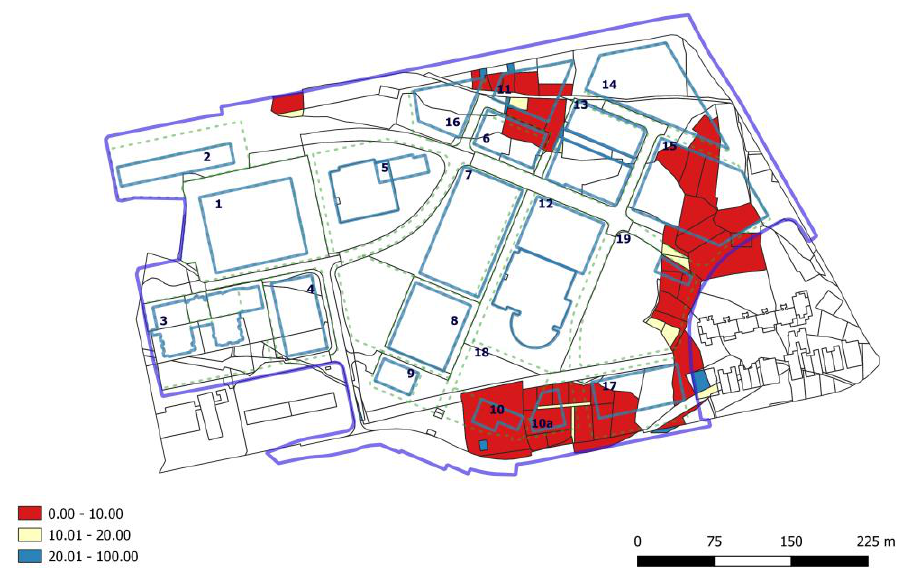
Figure 6. Performance Index of private cadastral parcels in the project area of Campus, University of Split.